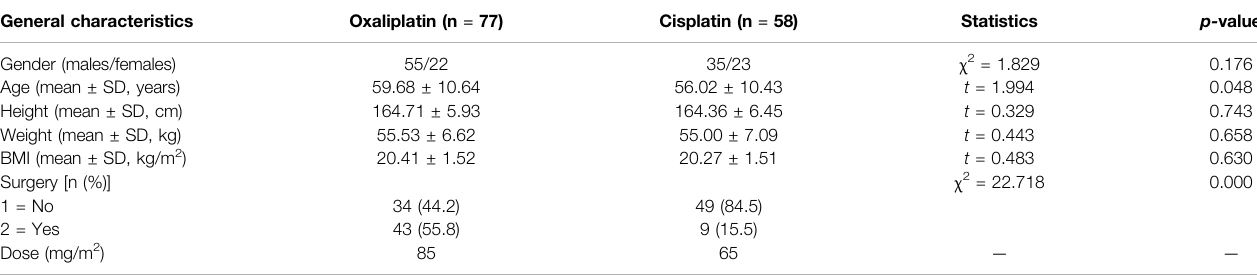
TABLE 2 | General characteristics of the study